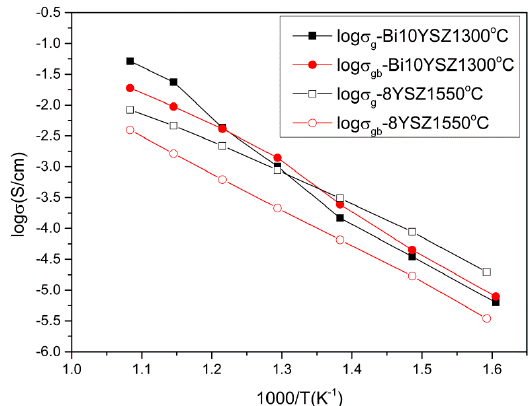
Figure 10. Grain and grain boundary Arrhenius curve of 8YSZ sintered at 1550 °C and 2Bi-10YSZ sintered at 1300 °C.